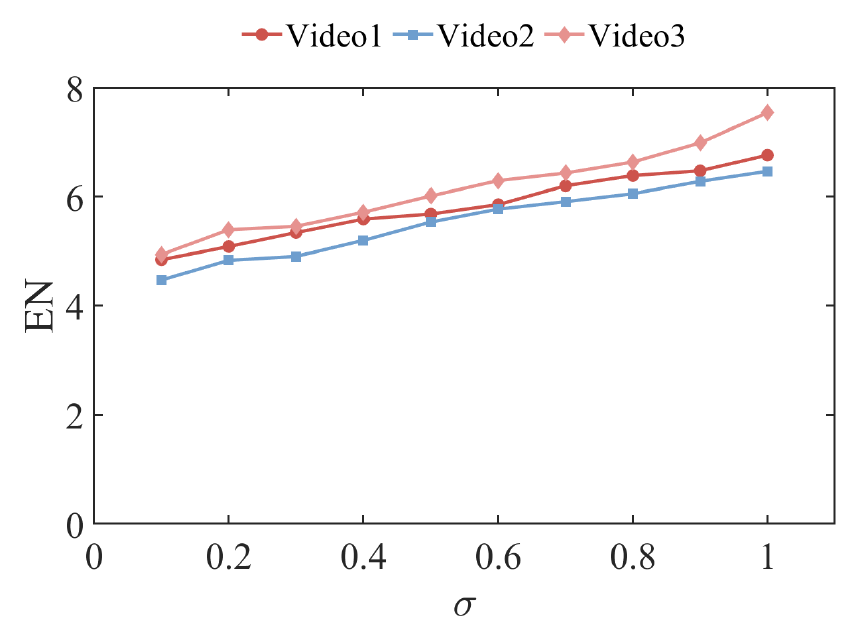
Figure 12. EN results for Video 1 (containing the Align 700L V2 obstacle object), Video 2 (containing the DJI F450 obstacle object), and Video 3 (containing the DJI Mavic 2 Pro obstacle object) using the proposed algorithm at different σ values. The higher the EN, the better the performance.